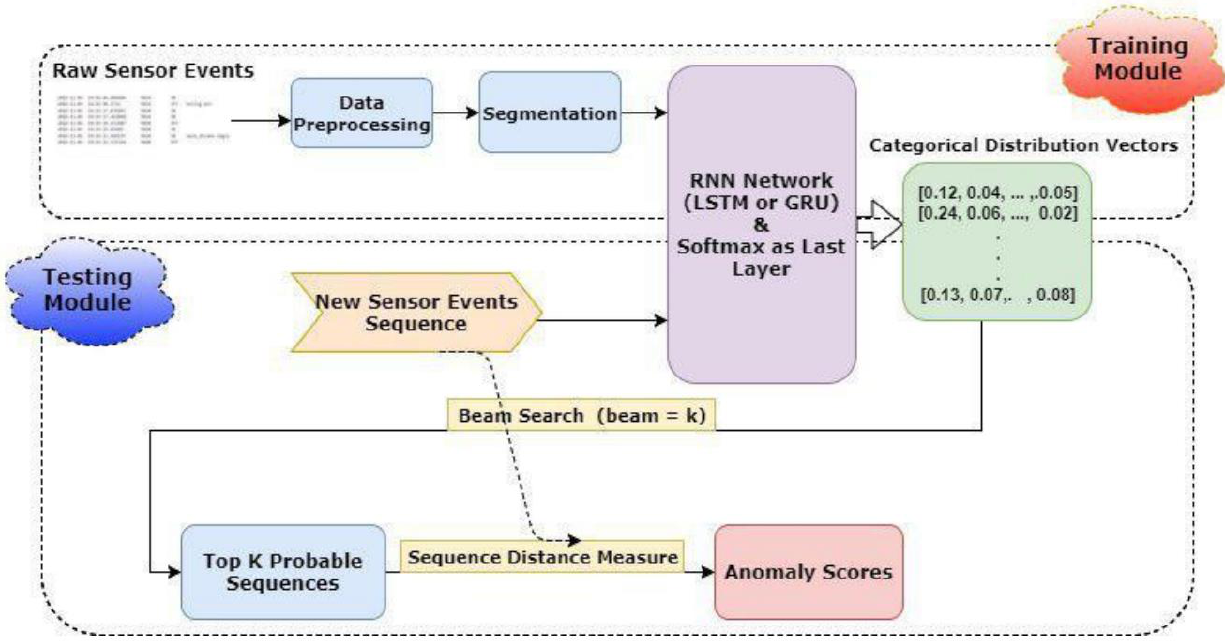
Figure 4. The overall scheme of the proposed method [76] .